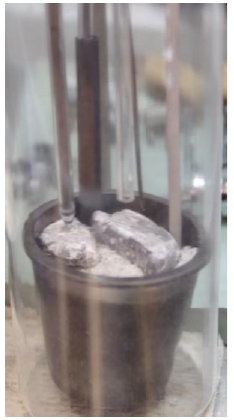
Figure 1. Photograph of the experimental cell .